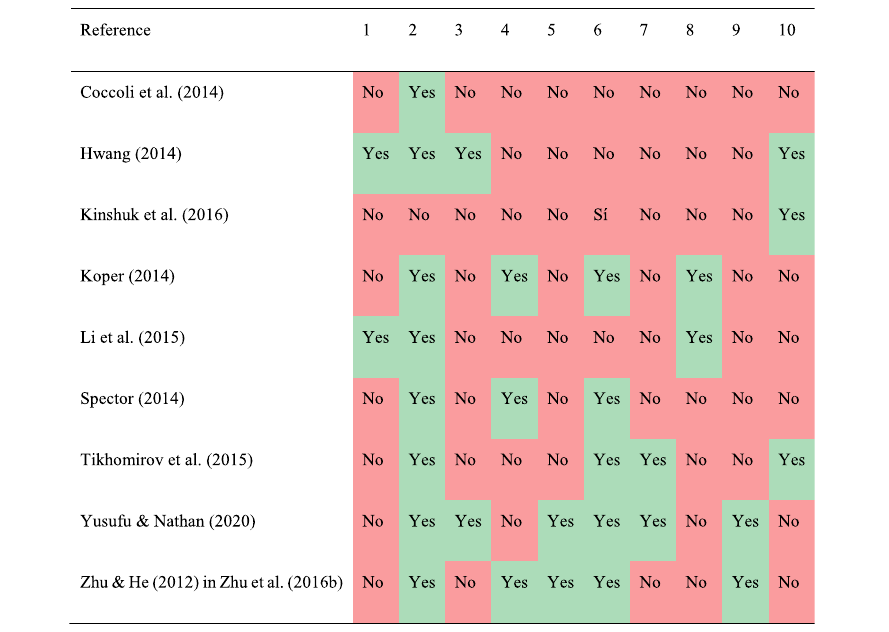
Table 1 Coding query matrix about definitions according to